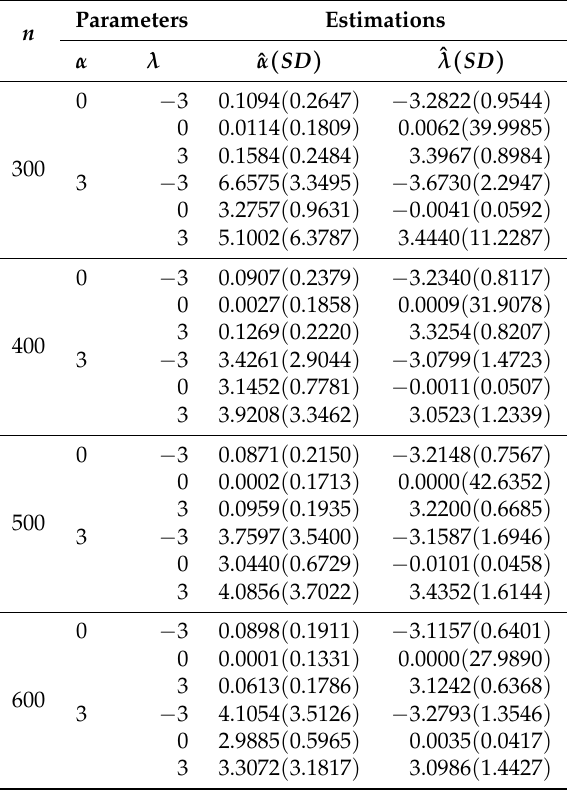
Table 7. Empirical means and standard deviations for ML estimators using Fisher-scoring method (with µ = 0 and σ =